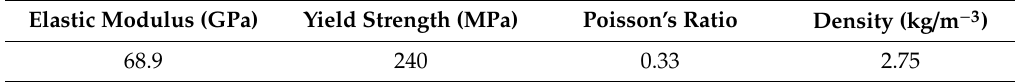
Figure 4. Measurement of the initial residual stress.